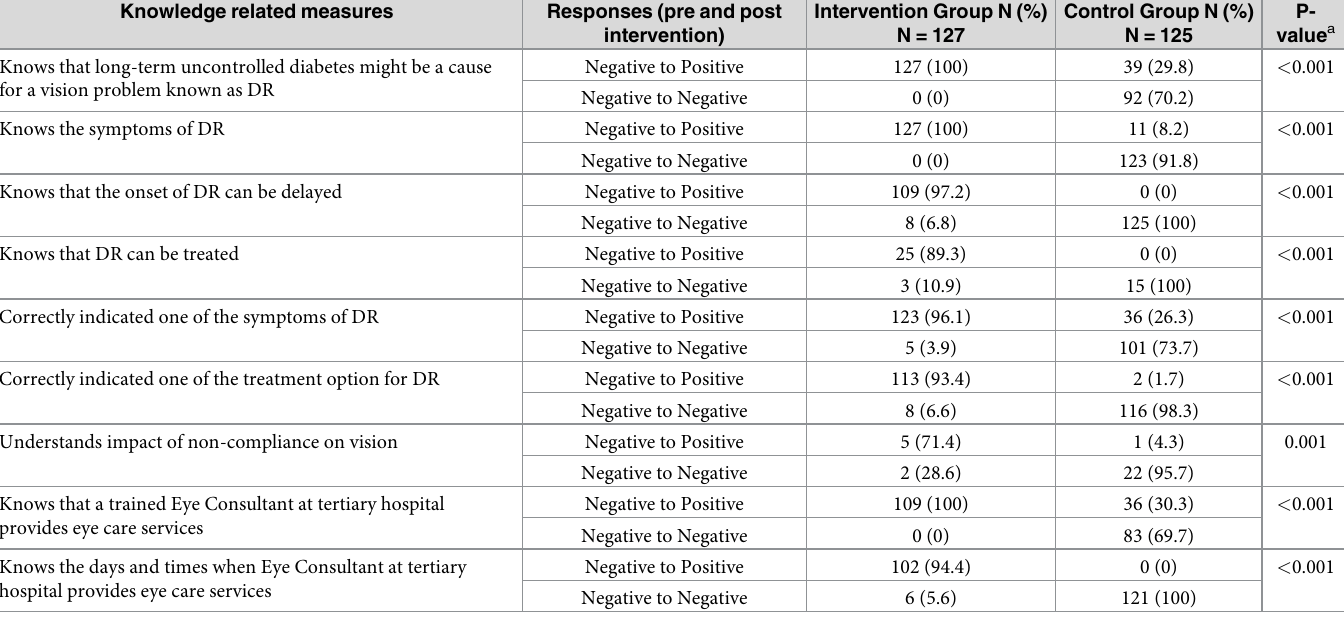
Table 4. Comparison of number of participants who responded negatively to knowledge measures during